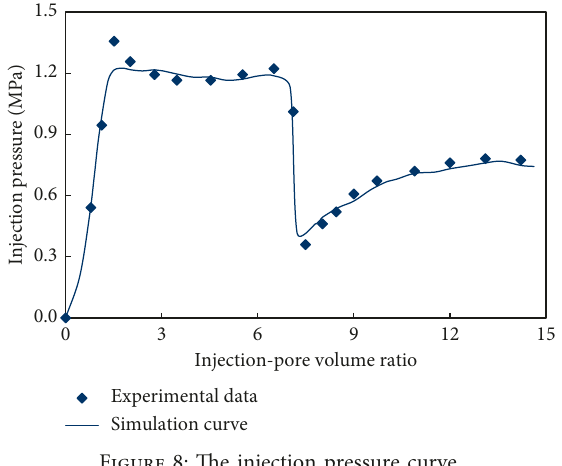
Figure 8: The injection pressure curve.